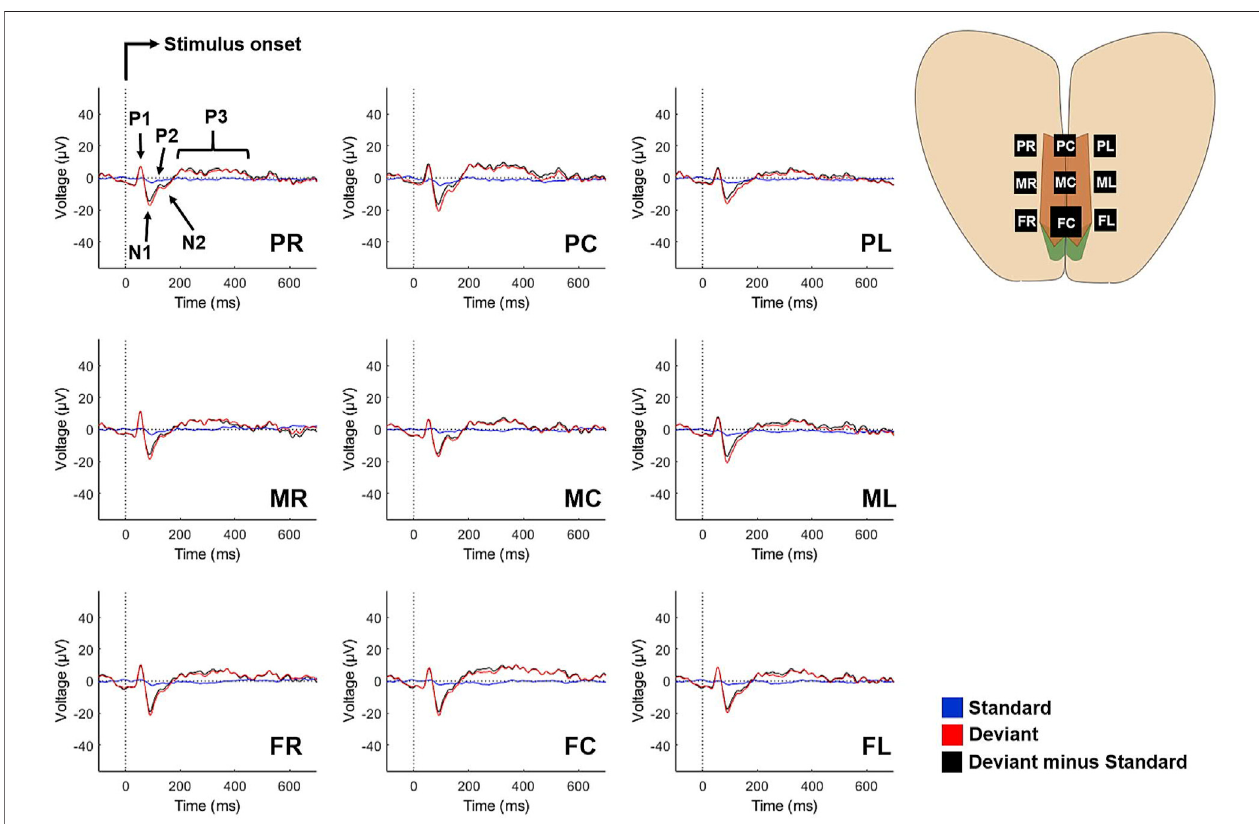
FIGURE 3 | Grand average ERPs elicited by the standard sound (blue), deviant sound (red) and their difference curves (black) at all electrode sites. Traces are averaged from 10 animals. The components P1-N1-P2 are characteristic for pre- and early attentive auditory signal processing, while N2 and P3 indicate conscious stimulus